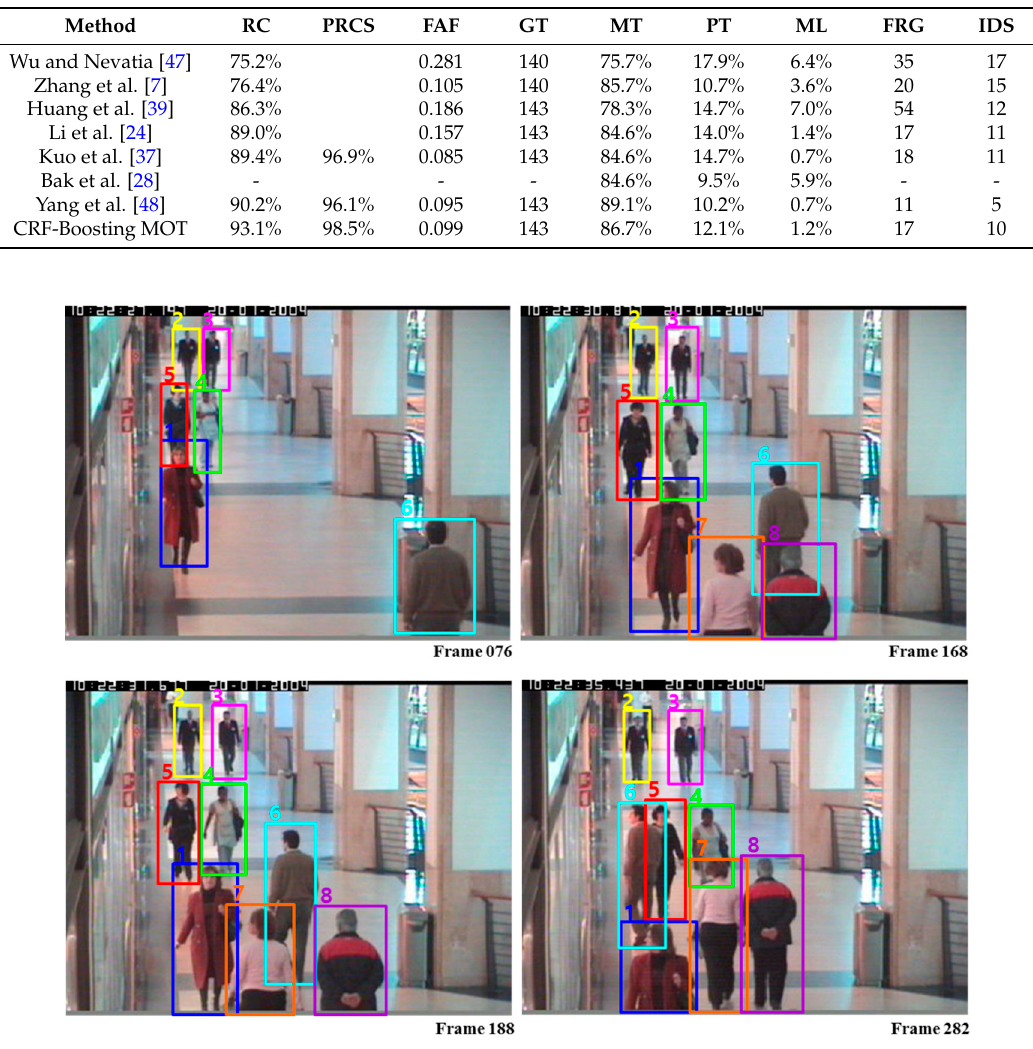
Figure 5. Tracking results of our system on CAVIAR.